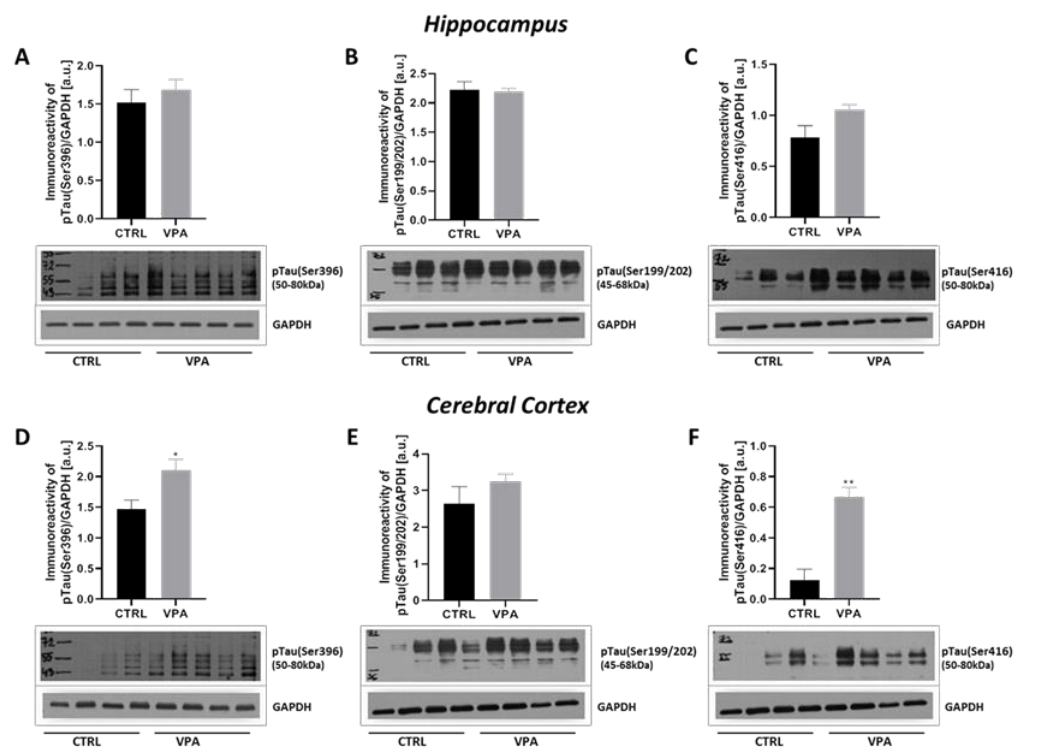
Figure 5. The effect of prenatal exposure to VPA on the phosphorylation state of Tau protein in the rat brain. Immunore- activity of pTau(Ser396), pTau(Ser199/202), and pTau(Ser416) protein in control and VPA-exposed rats was monitored using Western blot analysis. Densitometric analysis and representative pictures of pTau(Ser396), pTau(Ser199/202), and pTau(Ser416) in the hippocampus ( A – C ) and cerebral cortex ( D – F ) were shown. Results were normalized to GAPDH levels. Data represent the mean values ± SEM from n = (4–8) independent experiments in the hippocampus: ( A ) n = 8 (CTRL), n = 8 (VPA); ( B ) n = 4 (CTRL), n = 4 (VPA); ( C ) n = 5 (CTRL), n = 5 (VPA); and n = (3–8) independent experiments in the cerebral cortex: ( D ) n = 8 (CTRL), n = 8 (VPA); ( E ) n = 4 (CTRL), n = 5 (VPA); ( F ) n = 3 (CTRL), n = 3 (VPA). * p < 0.5, ** p < 0.01, vs.